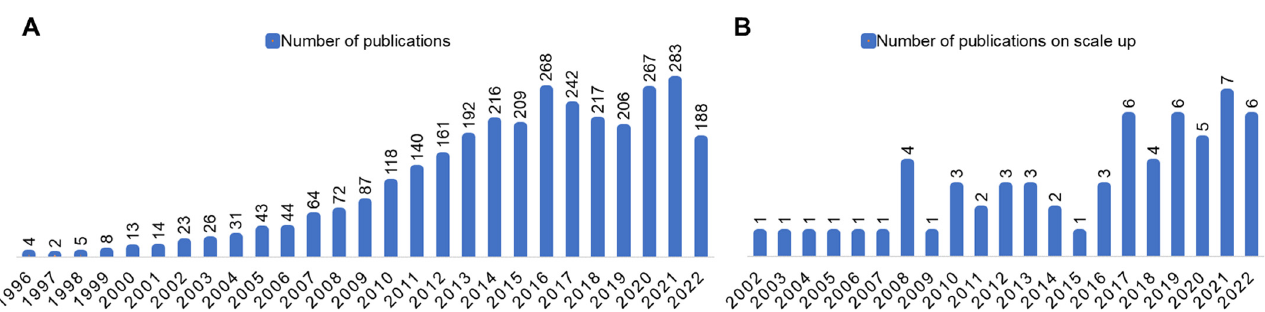
Figure 2. Bibliographic search analysis of SLNs from the PubMed database [19]. Search term “Solid lipid nanoparticles [Title/Abstract]” ( A ) yielded 3143 publications; “Scale-up of solid lipid nanoparticles [Title/Abstract]” yielded 62 publications ( B ).